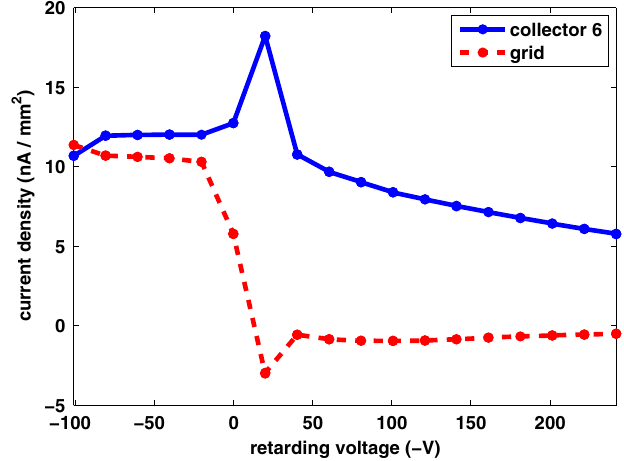
FIG. 8. Resonant enhancement in wiggler data, 45 bunches, 1 . 25 mA = bunch, e þ , 2.1 GeV, 14 ns. Note that there are 12 collectors, so collector 6 is one of the central ones.